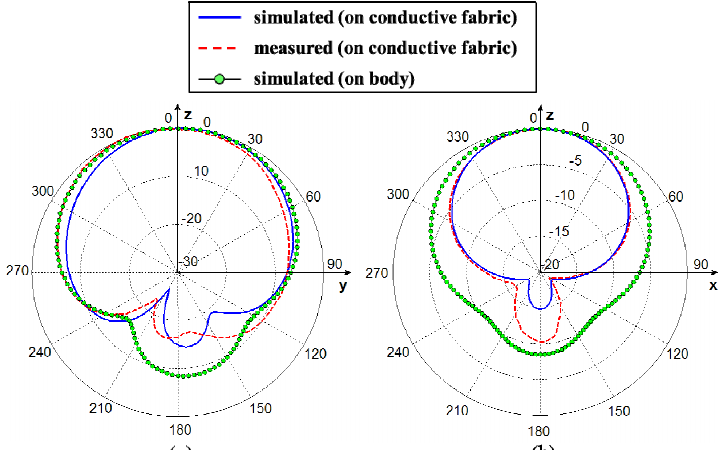
Figure 12. ( a ) E-plane and ( b ) H-plane normalized radiation patterns of the proposed MD-antenna at 868 MHz, on a conductive fabric and on a